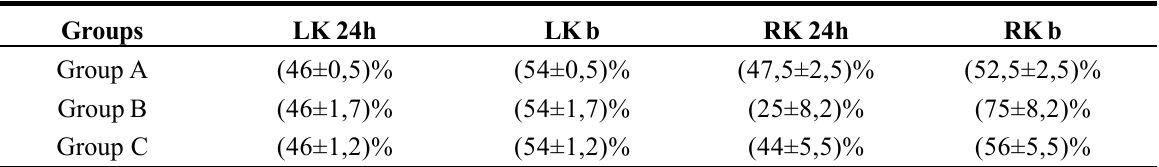
Table 1 - Arithmetic means and standard deviations of split kidney functions, in all groups. LK b: Left Kidney (basal); RK b: Right Kidney (basal); LK 24h: Left Kidney 24 hours; RK 24h: Right Kidney 24 hours.